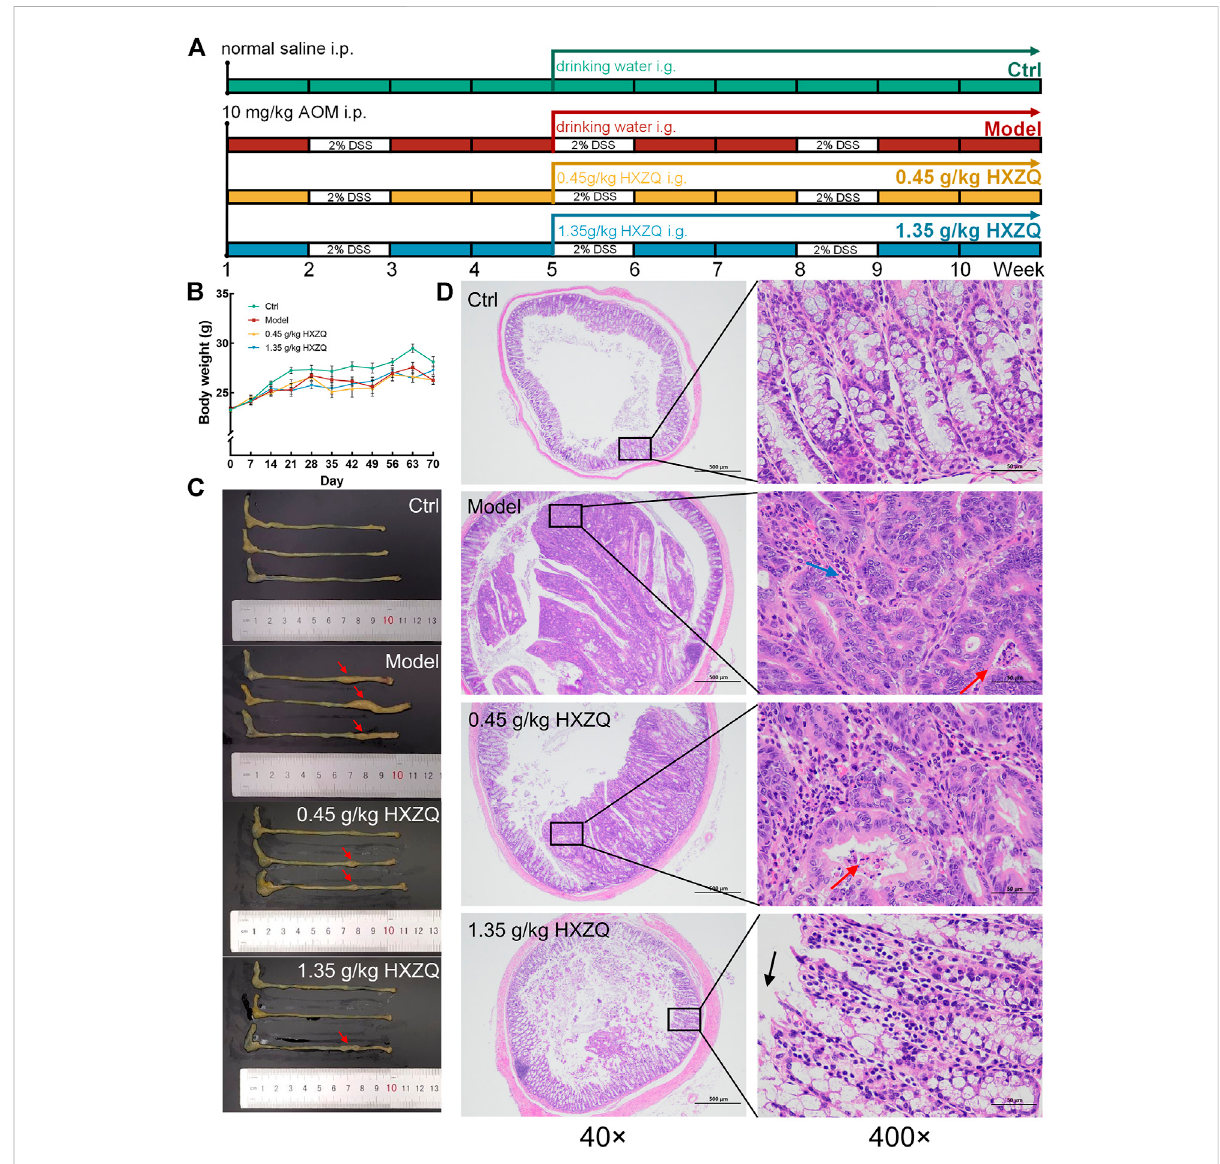
FIGURE 1 The anti-CAC effect of HXZQ on AOM/DSS mice. (A) Schematic overview of the experimental protocol. (B) Body weight was monitored every week during the entire experimental period (n = 8). (C) HXZQ suppressed the tumor growth in AOM/DSS mice ( n = 3). (D)